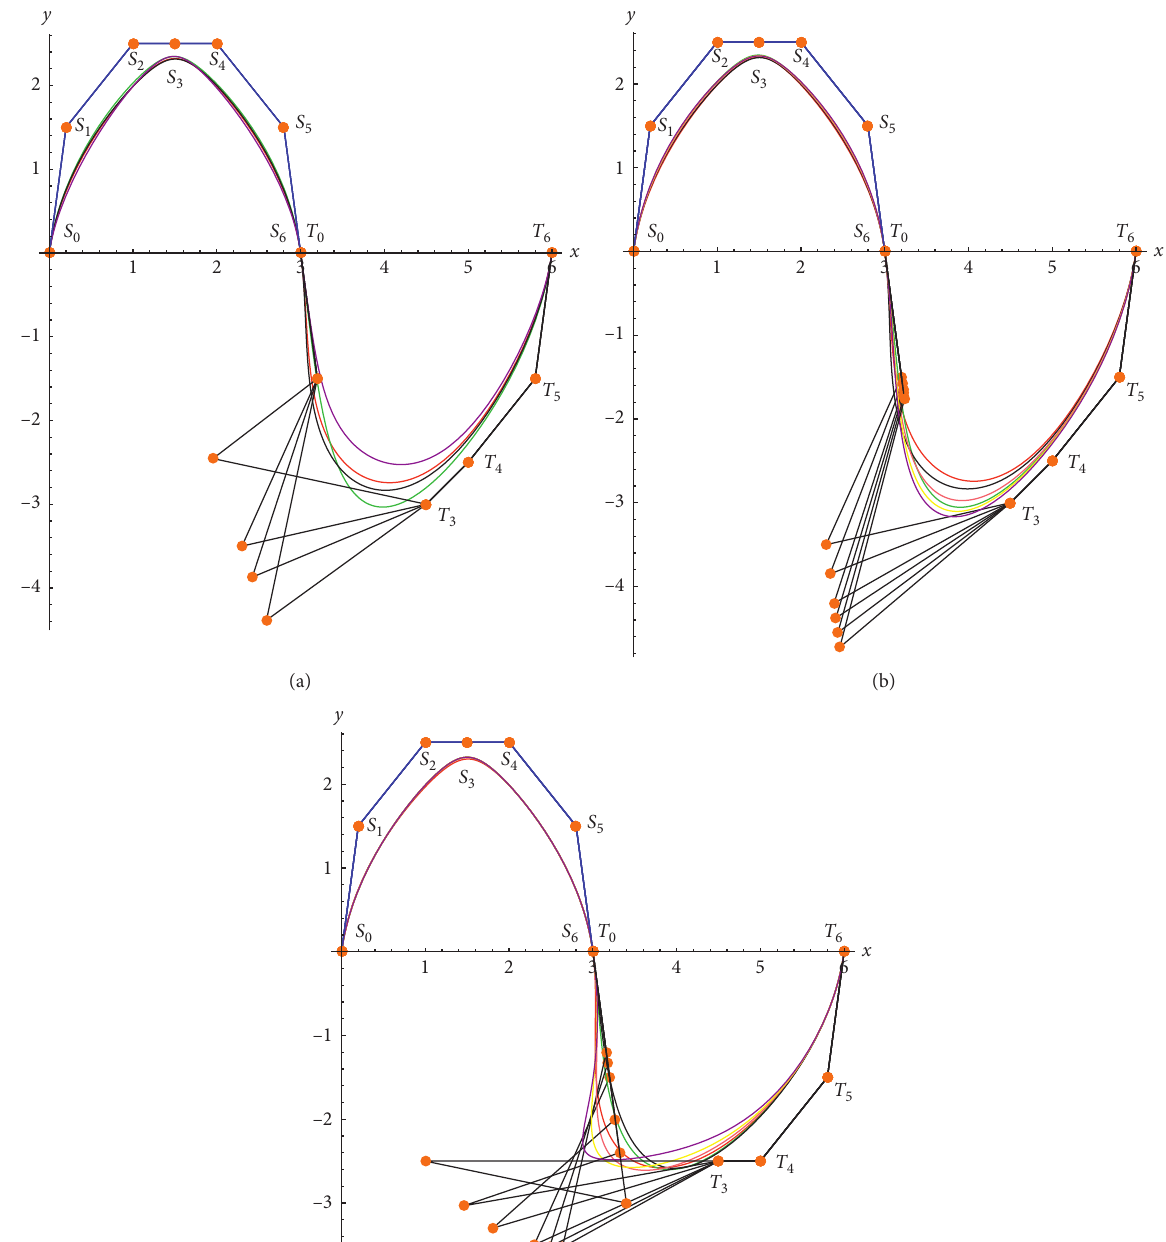
Figure 8: C 2 continuity of ST-B´ezier curve segments with various shape parameters. (a) μ � ω � μ 1 � ω 1 � 0 , 0 . 5 , 0 . 2 , − 0 . 5. (b) μ � ω � 0 , 0 . 2 , 0 . 4 , 0 . 5 , 0 . 6 , 0 . 7 , μ 1 � ω 1 � 1. (c) μ � ω � 0 , μ 1 � ω 1 � 0 , 0 . 5 , 1 , − 1 , − 1 . 5 , −